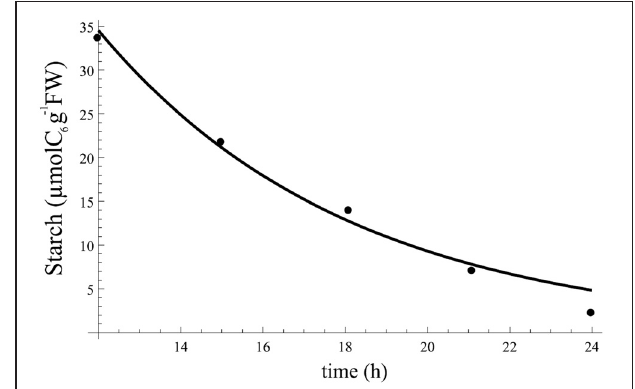
FIGURE A2 | Starch profile at night resulting from fitting Equation (A1) to data and using a β = b β = 0 . 16. Points indicate the data to which Equation (A1) was